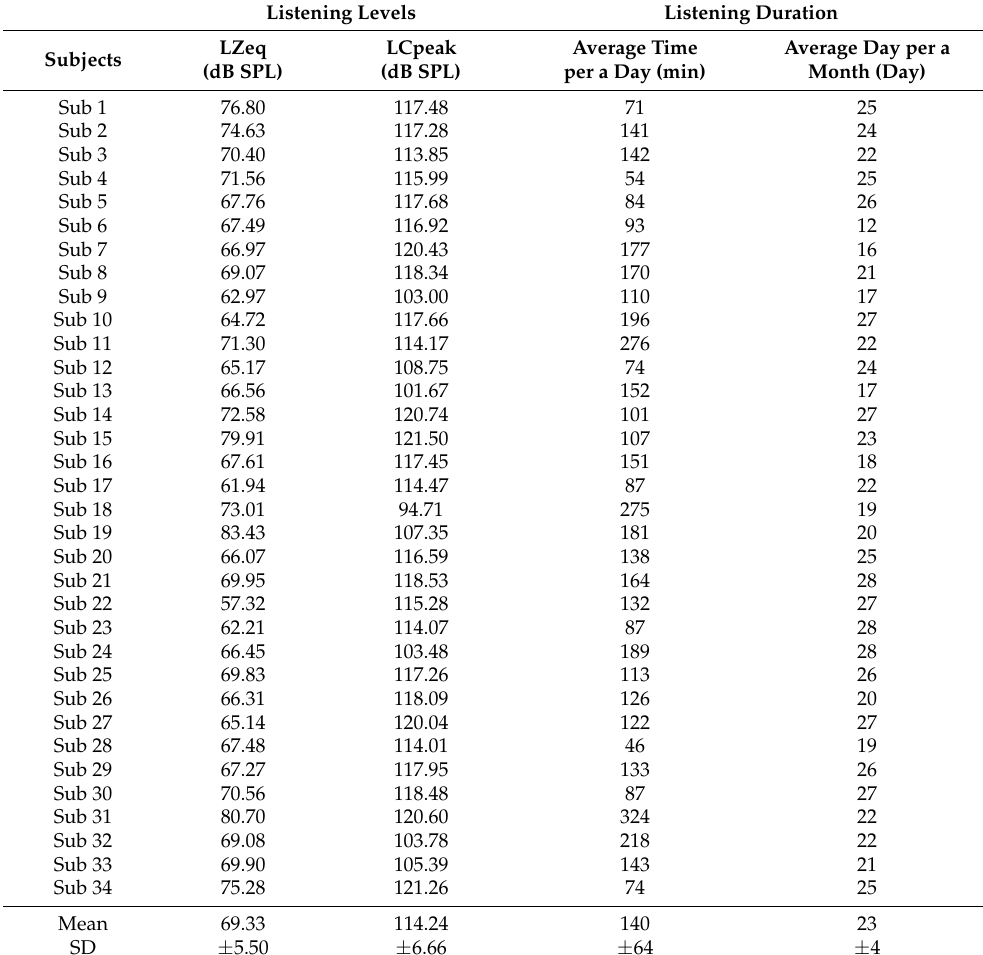
Table 1. Individual data for listening levels and times measured for four weeks (N =